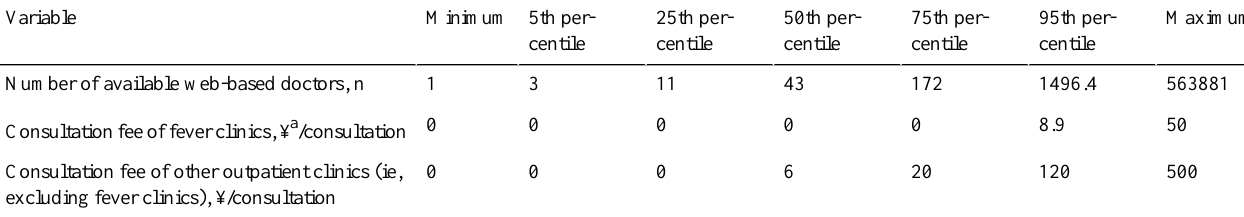
Table 1. Number of doctors and consultation fees for internet hospitals in China.